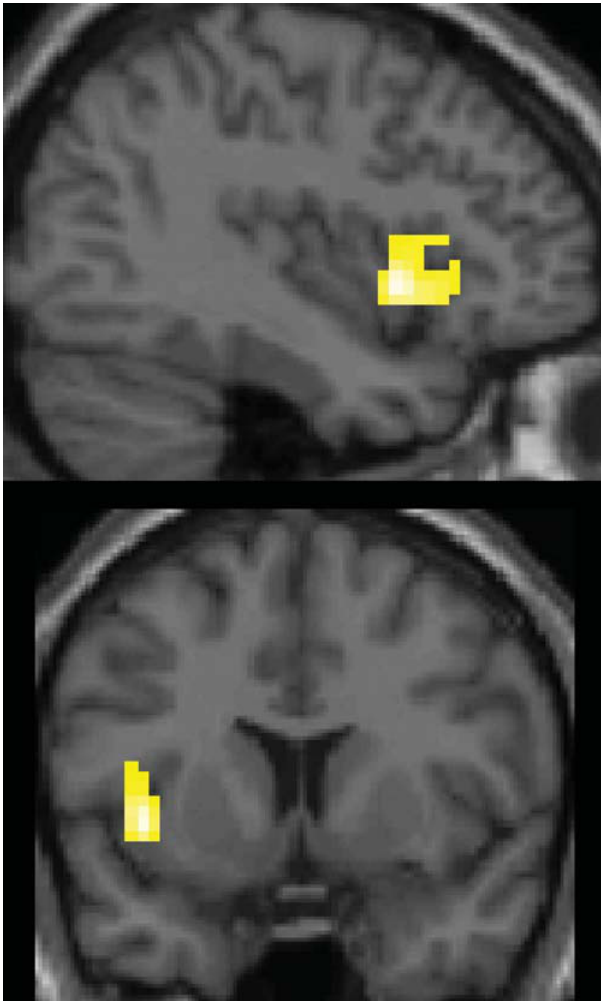
Figure 3. Differential responses to actively and passively learned melodies. Increased BOLD effect in response to the actively learned melodies compared with the passively learned melodies was located in the left anterior insula, extending to the deep fronto-opercular cortex (p , 0.005, k . 100, Z-score . 3.0, slices are at x= 2 39 and y=9).